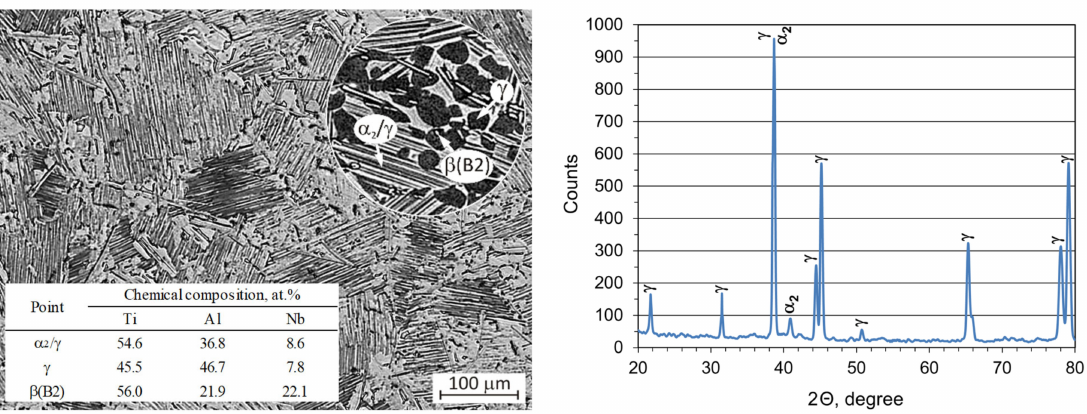
Figure 3. Microstructure and X-ray diffraction patterns of Ti-45Al-8Nb-0.5(B,C) alloy. The microstructure of the Ti-45Al-5Nb-2Cr-1Mo-0.5(B,C)-0.2Si alloy with a complex